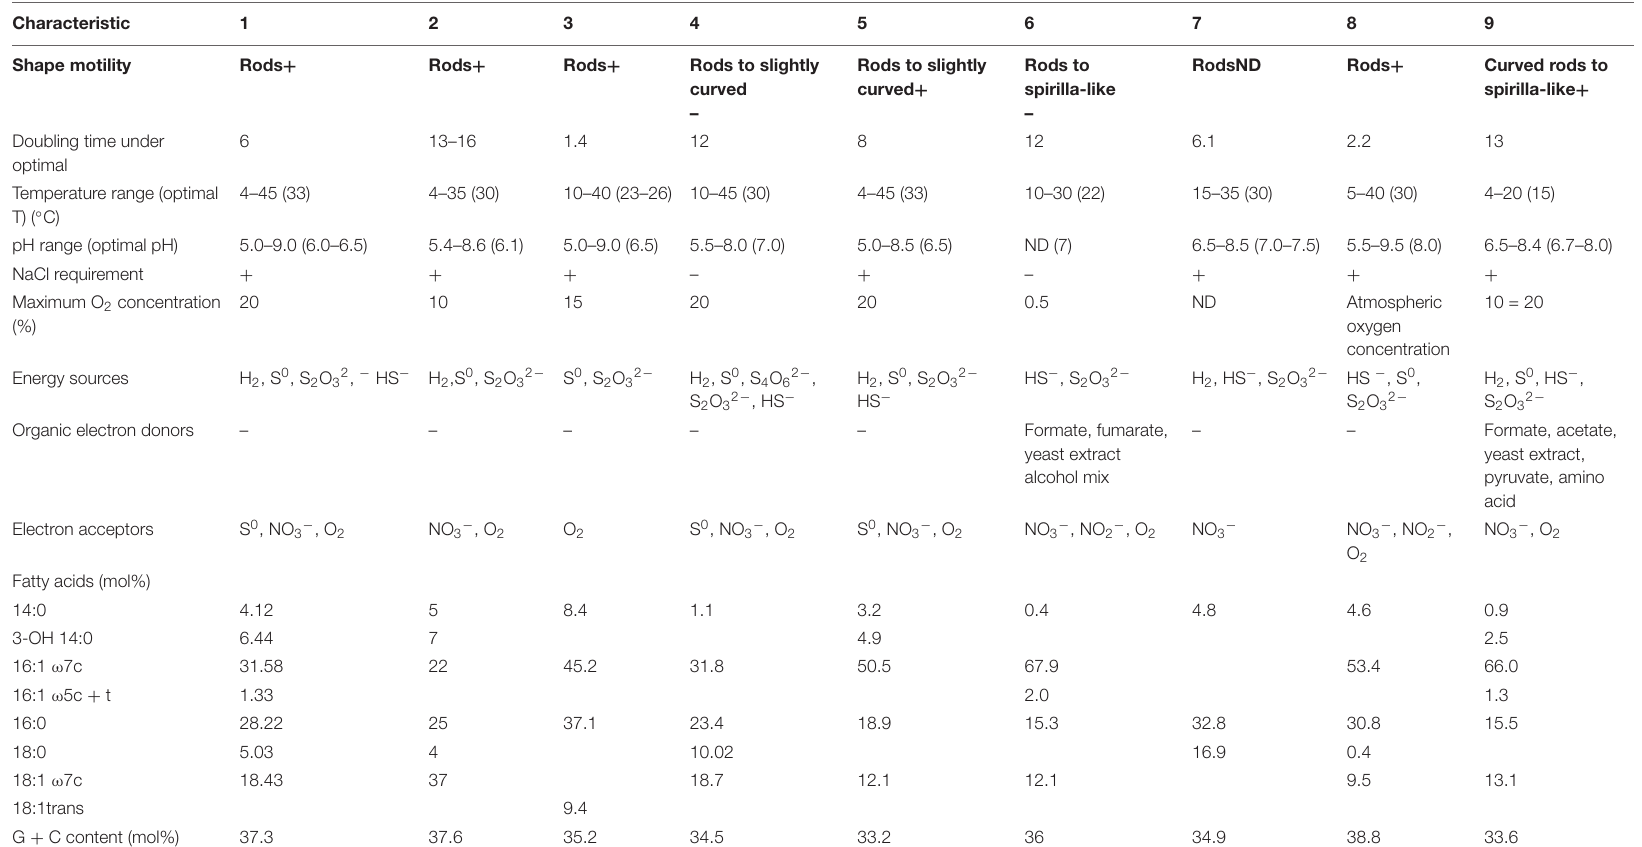
TABLE 1 | Comparison of characteristics of Sulfurimonas hydrogeniphila NW10T sp. nov. with related species of the genus Sulfurimonas .